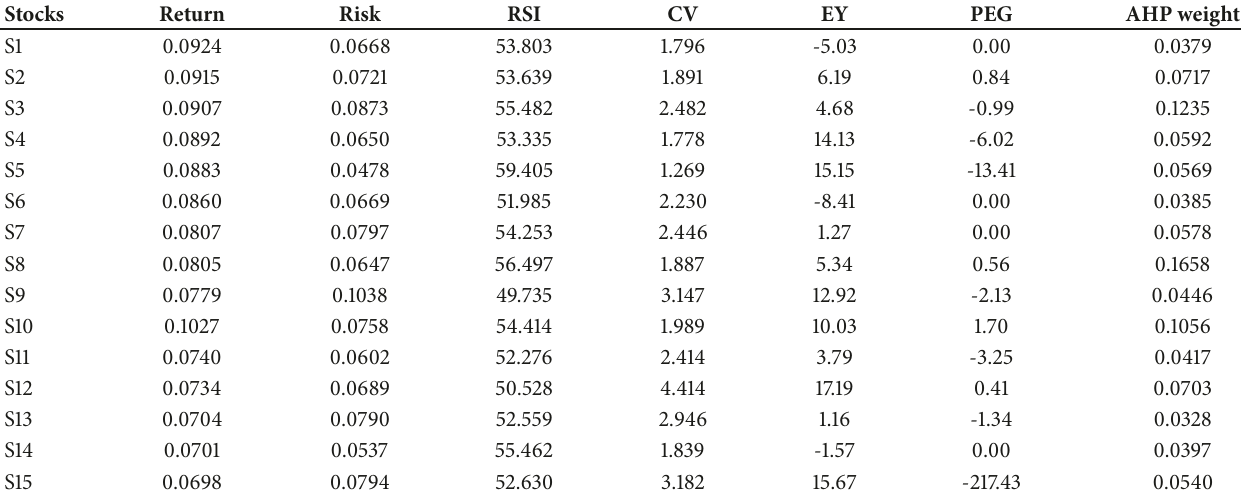
Table 6: Input data for Cluster 3.